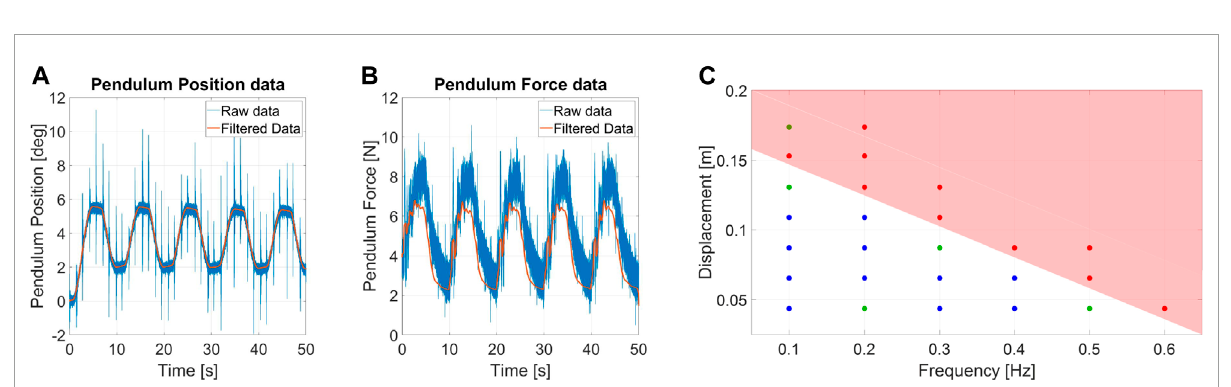
FIGURE 9 Measurement of (A) angular position and (B) force estimation for a sinusoidal displacement disturbance experiment. The used condition for the test are f = 0 . 1 Hz and A D = 4 cm . (C) Chart of the ERrelated to displacement perturbations for Alter-Ego.